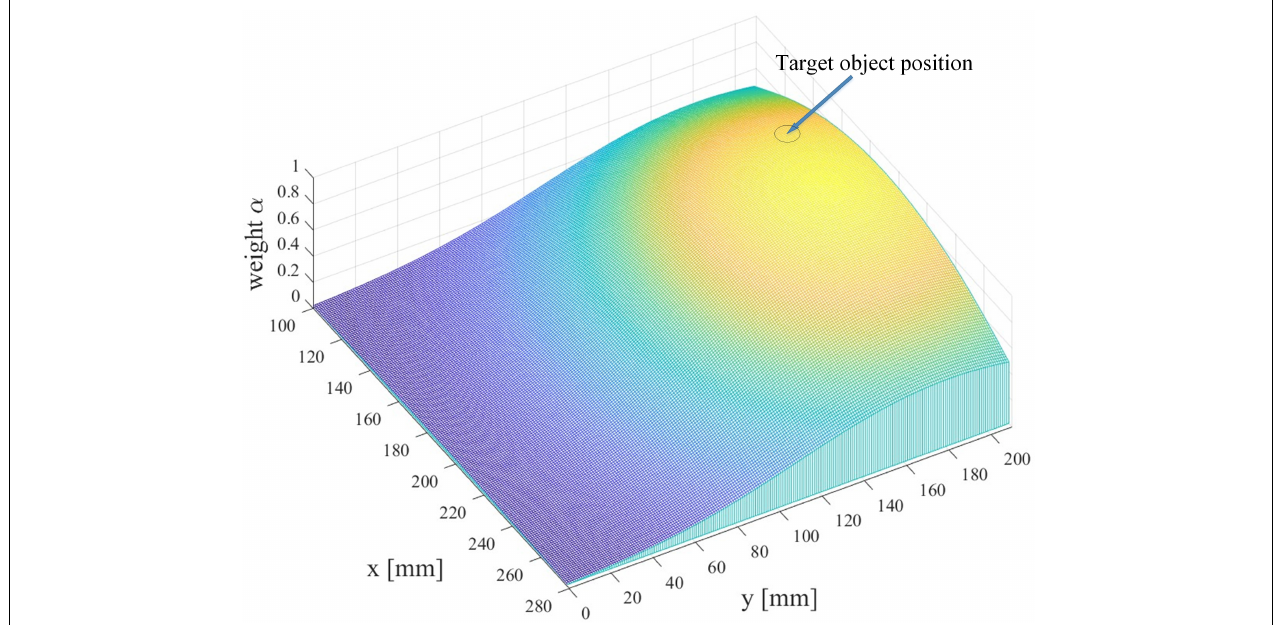
FIGURE 5 | The distribution of the arbitration factor α